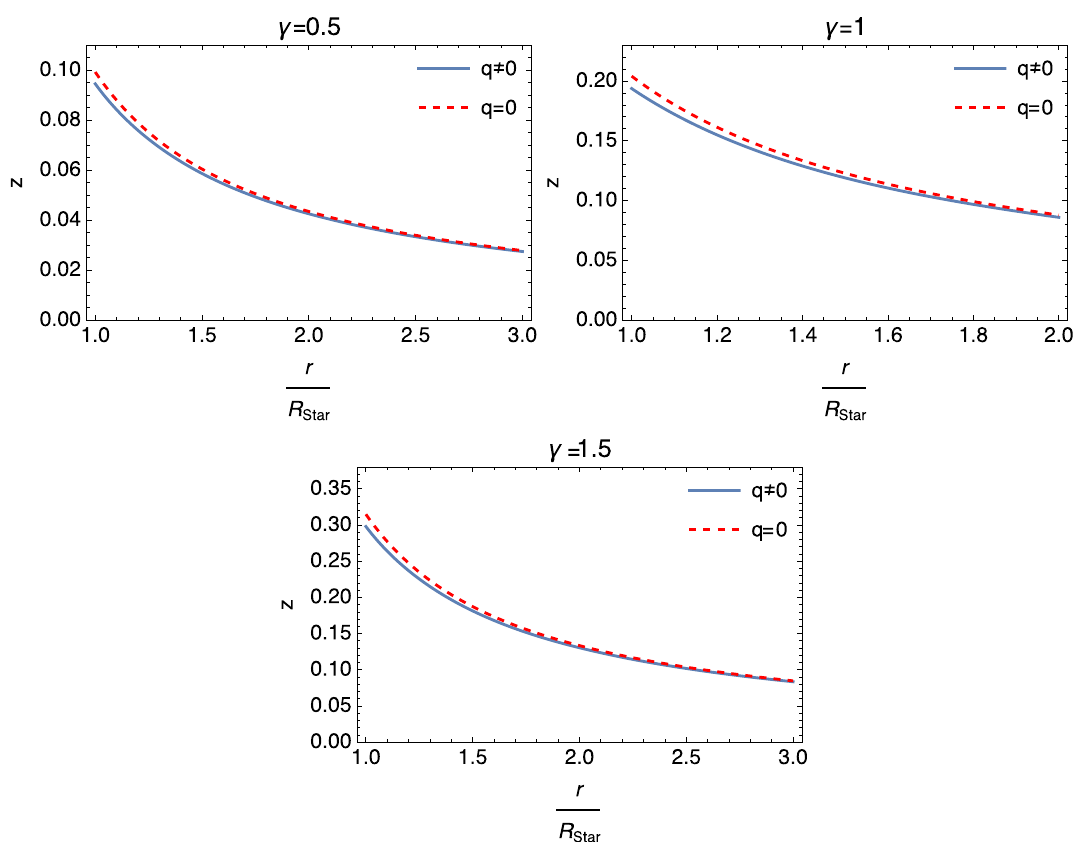
Fig. 15 The graphs show the variation in the redshift z versus r for the compact object HerX-1. The plots are generated for static charged R Star ( q (cid:8)= 0 ) and static uncharged ( q = 0 ) cases. Variation for each case are shown on the same graph for different values of deformation parameter γ